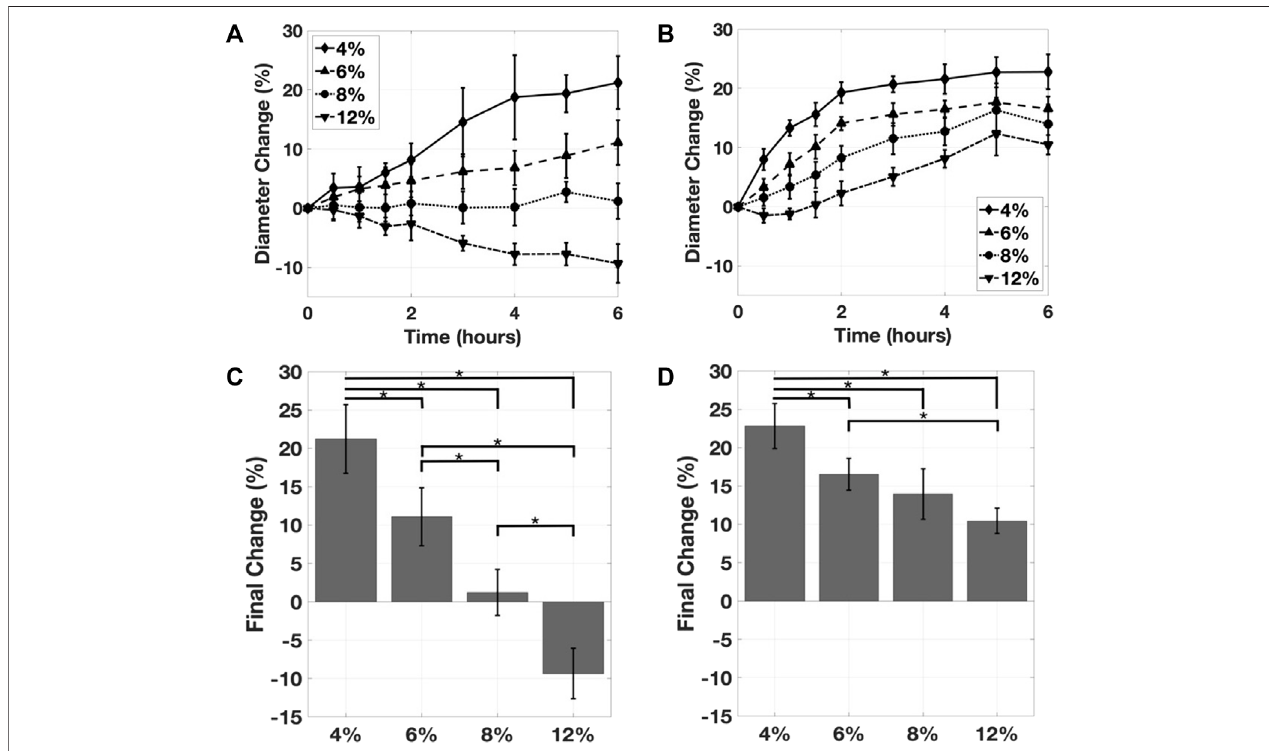
FIGURE5|(A) Theeffectofgelatinconcentrationonthemeaninner diameterexpansion,with0.05%glutaraldehyde. (B) Theeffectofgelatinconcentrationonthe meaninnerdiameterexpansion,with0.50%glutaraldehyde.Theeffectofgelatinconcentrationontheinnerdiameterexpansionasmeasuredatthetimepoint,for (C) the 0.05% glutaraldehyde and (D) the 0.50% glutaraldehyde samples. Mean ± s.d.; * p <